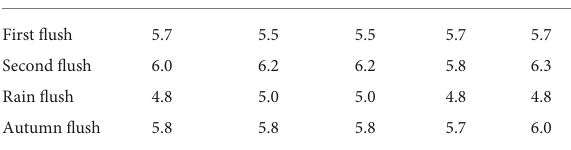
TABLE 4 Taster’s evaluation of promising purple tea germplasm TRA